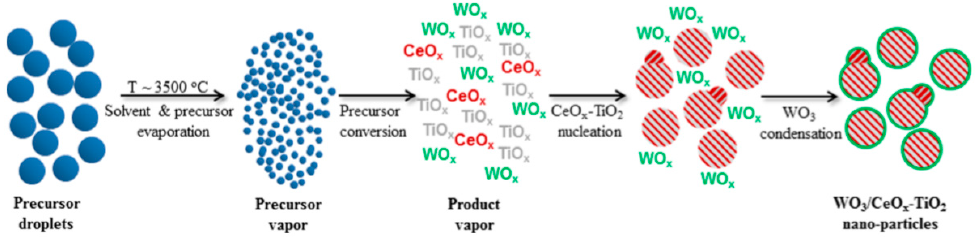
Figure 14. Schematic representation of a feasible mechanism of WO 3 /CeO x –TiO 2 nanoparticles formation during flame-spray synthesis [88].